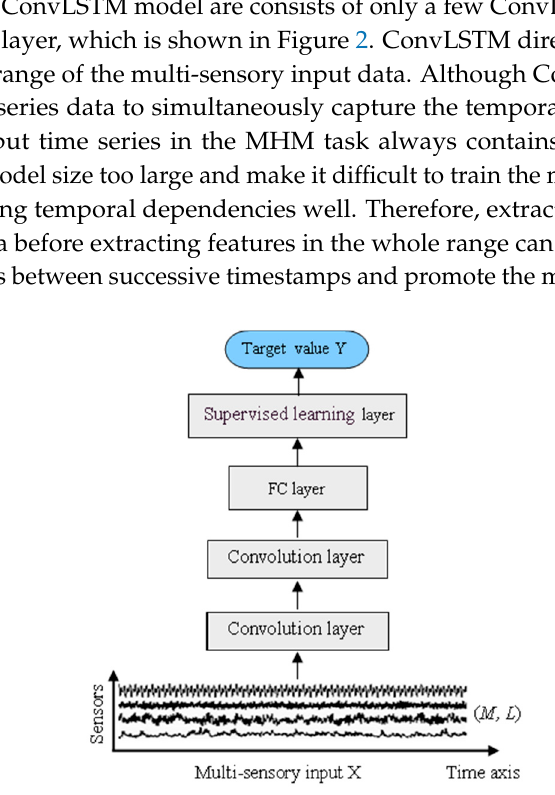
Figure 2. The framework of the basic ConvLSTM model.